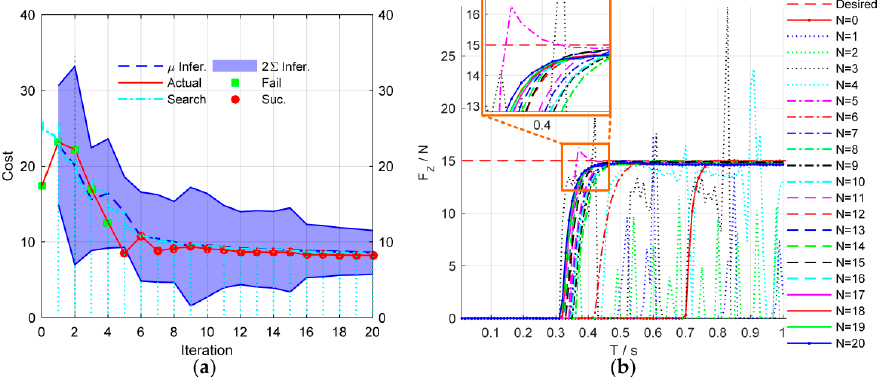
Figure 8. Simulation results of force control learning system. ( a ) The cost curve of learning process; the blue dotted line and the blue shade are the predicted cost mean and the 95% confidence interval. ( b ) The performances of force control during learning process.